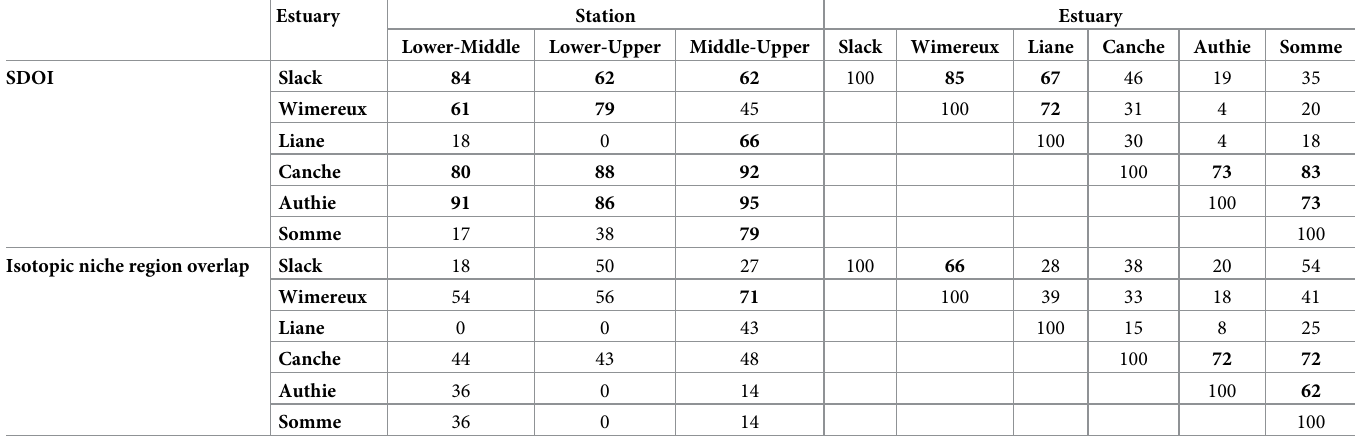
Bold characters indicate significantly high values ( >